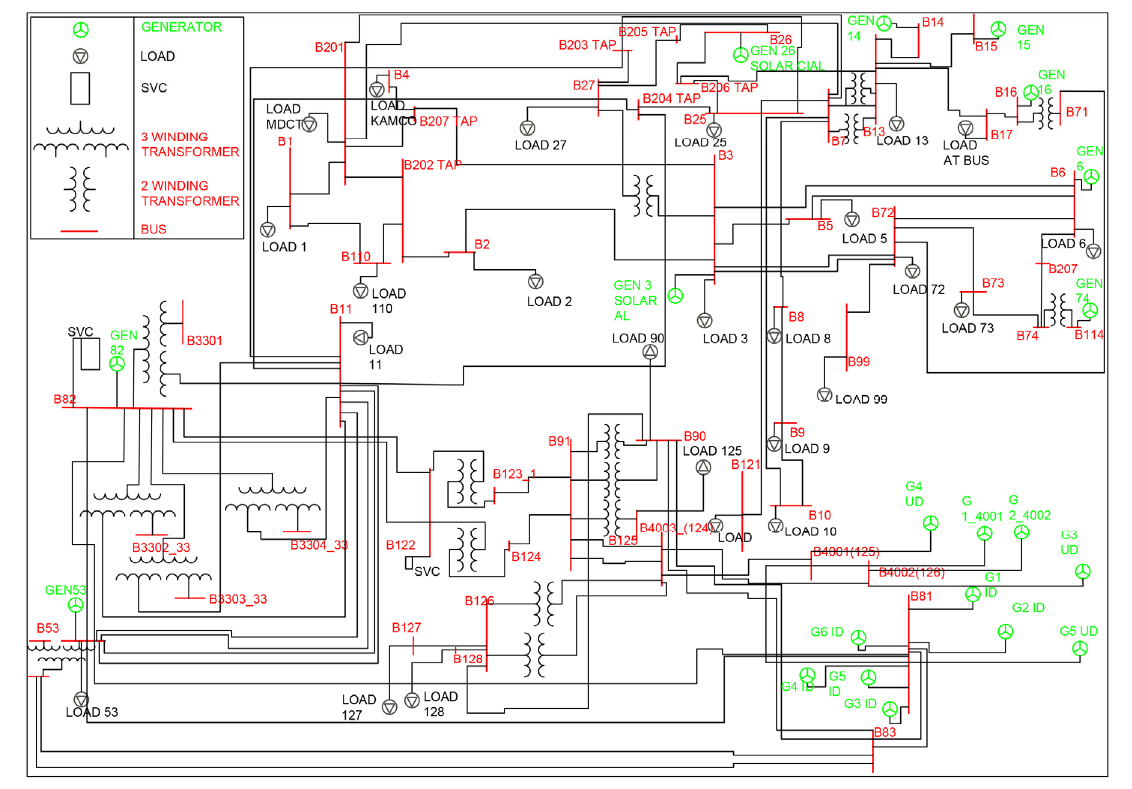
Figure 6. Single line diagram of the part of the interconnected transmission system of the supply entity of the state of Kerala, KSEBL. Table 9. Violation %, SICBs and apparent power flow in the branches of the practical system with an outage of L91_4003(1), resulting in congestion at L16_17 and L17_13 feeder (N-1 Contingency analysis).